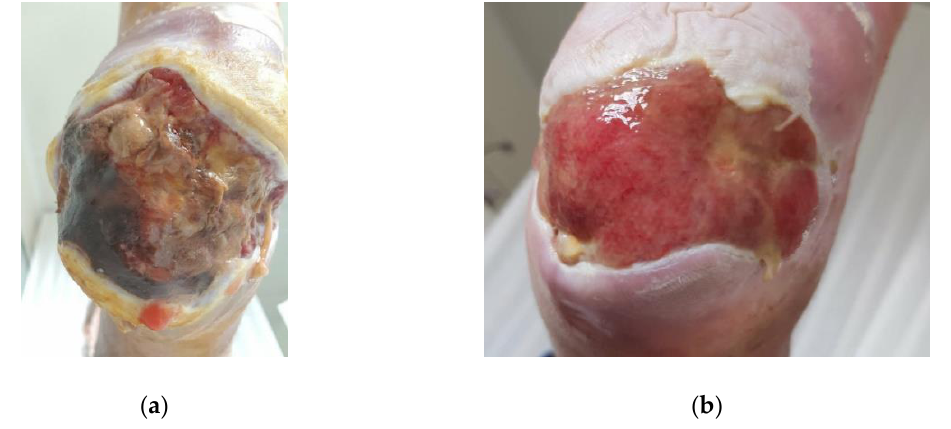
Figure 2. Clinical Case 1 of a Pseudomonas -infected diabetic ulcer, located on the heel, treated with L-Mesitran Soft. ( a ) Picture at the start of L-Mesitran Soft treatment on Day 0. ( b ) Wound after one month of treatment on Day 33.